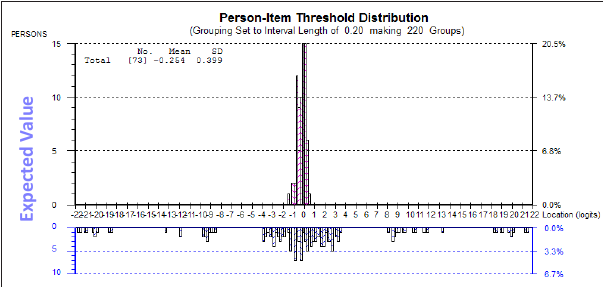
FIGURE 7: The person-item location distribution prior to